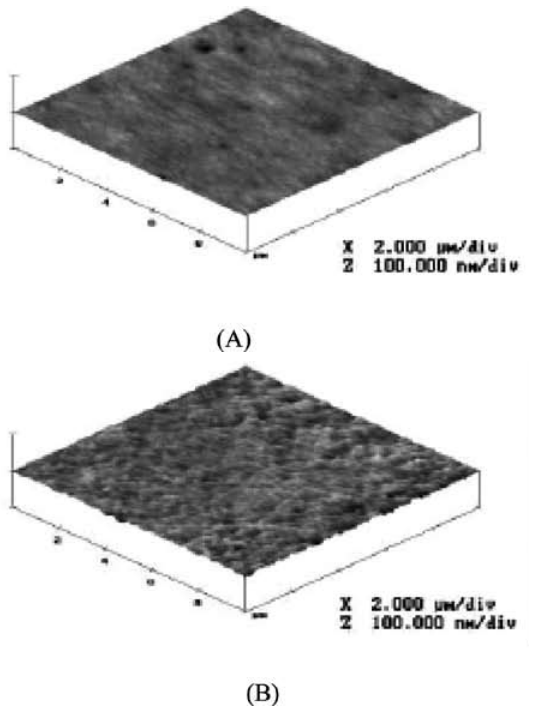
Fig. 3: AFM images of the silica wafers polished with (A) baseline 0.2 μ m 12wt% monosize silica slurry and (B) slurry with dry aggregates (Reprinted from reference 24 with permission from Elsevier). Fig. 2.3: Material Removal as function of standard deviation of the abra-